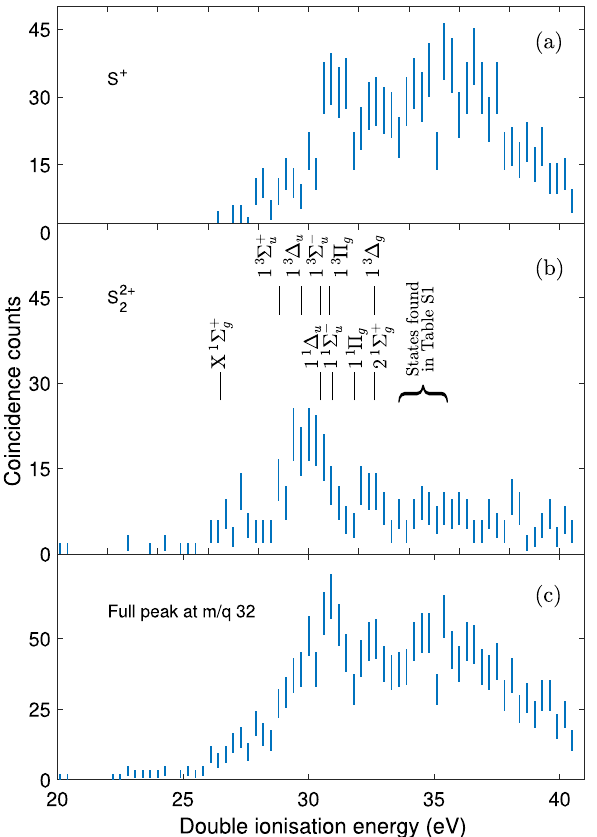
Figure 3. Double ionisation electron spectra from electron-ion coincidences at the photon energy of 40.81 eV. Each spectrum is based on electron pairs extracted in coincidence with all ions at mass to charge m / q = 32 ( c ), + + fragments ( a ). Error bars represent the statistical uncertainty of the included the S 2 2 ion ( b ) or one of its S coincidence counts. The middle panel shows calculated vertical excitation energies from the ground state of neutral S 2 . All calculated states can be found in Supplementary Table